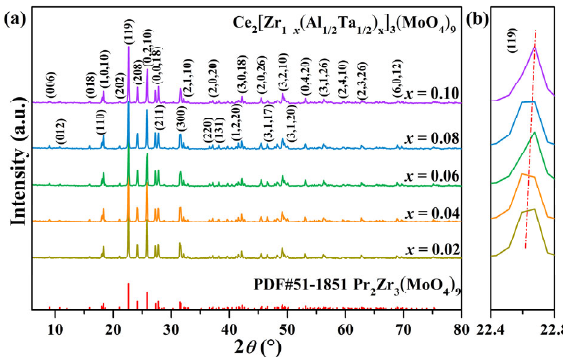
Fig. 1 XRD patterns of CZMAT ceramics sintered at 850 ℃ and the details in the range of 22.4°–22.8°.